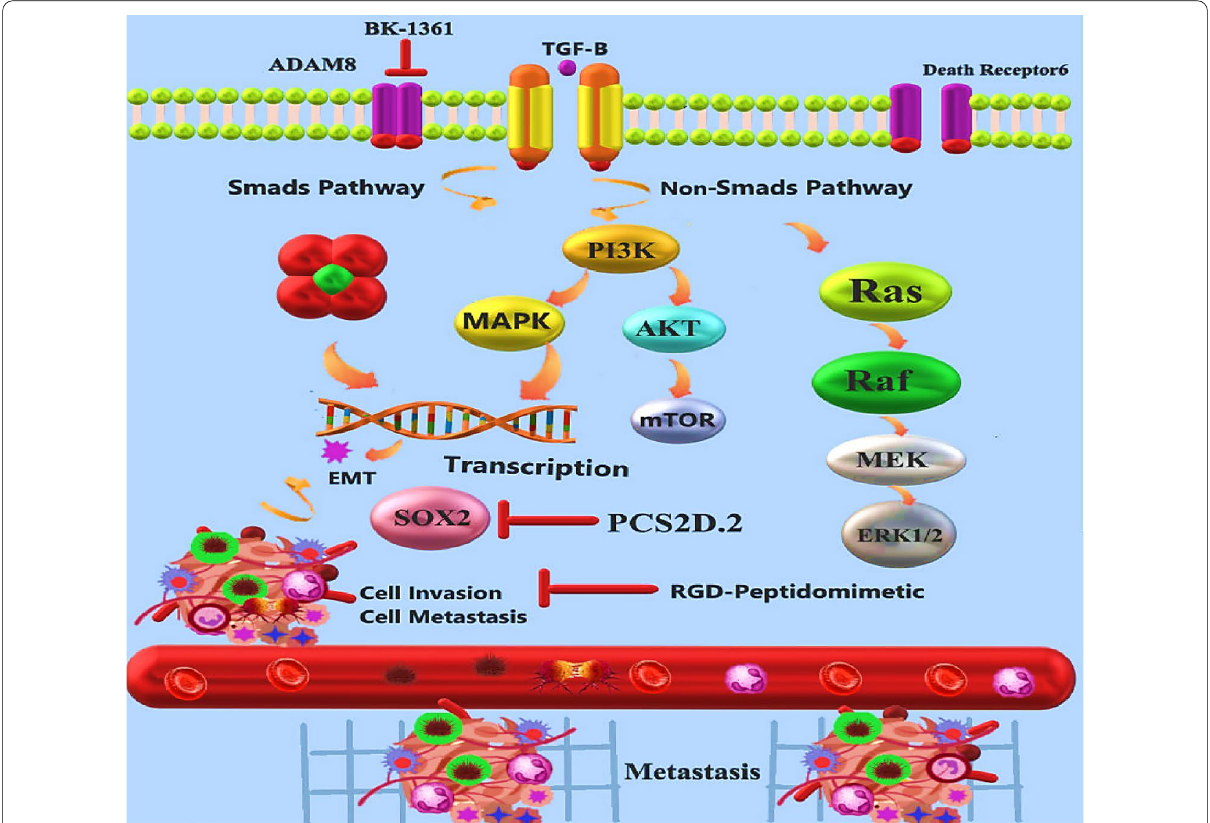
Fig. 4 Inhibition of cancer cells metastasis potency using